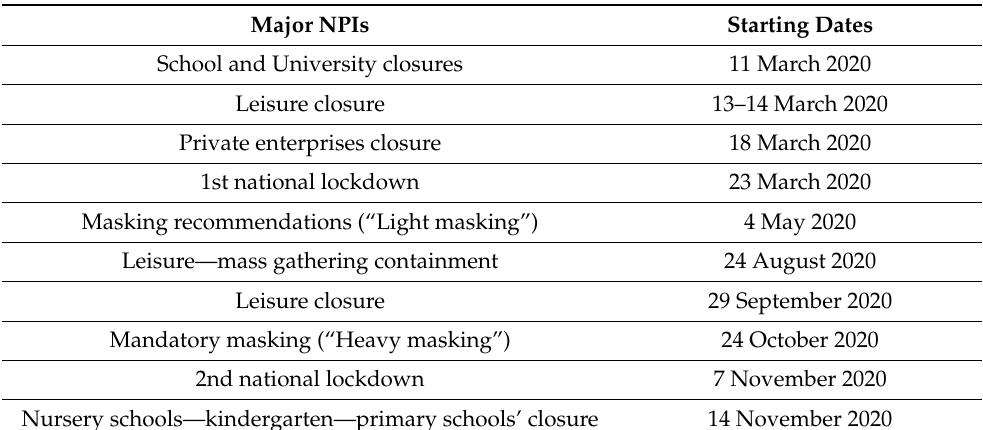
Table 1. Major NPIs implemented in Greece during the COVID-19 pandemic. Major